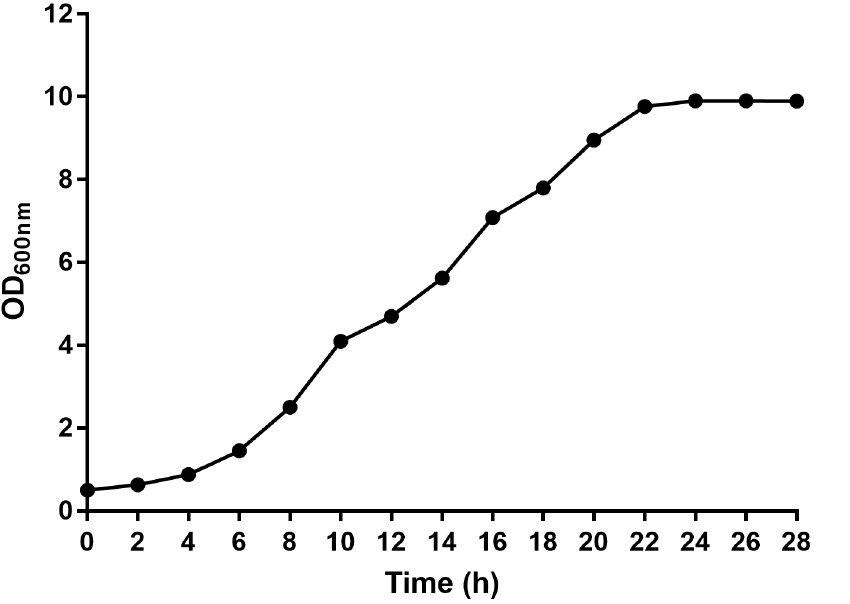
Fig 1. Growth curve of the Ralstonia solanacearum RS